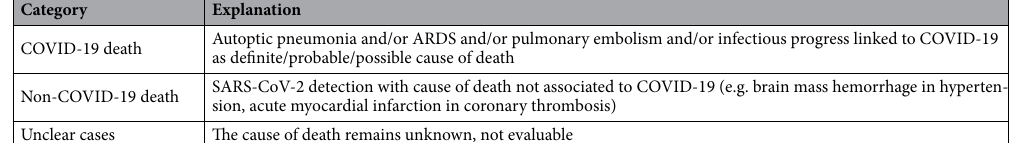
Table 6. Categorization of COVID-19 deaths using a adapted categorization of Edler et al. 8 . This table displays the established categorization of COVID-19 and non-COVID-19 death at the Institute of Legal Medicine, which was used to clarify all evaluated death cases corresponding to a RT-qPCR positive pre- or postmortem SARS-CoV-2 test. ARDS acute respiratory distress